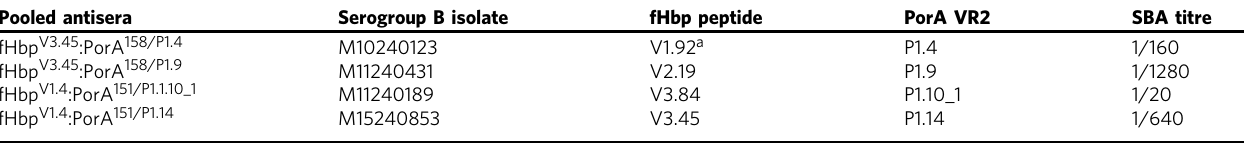
Table 2 Serum bactericidal assay titres Pooled antisera Serogroup B